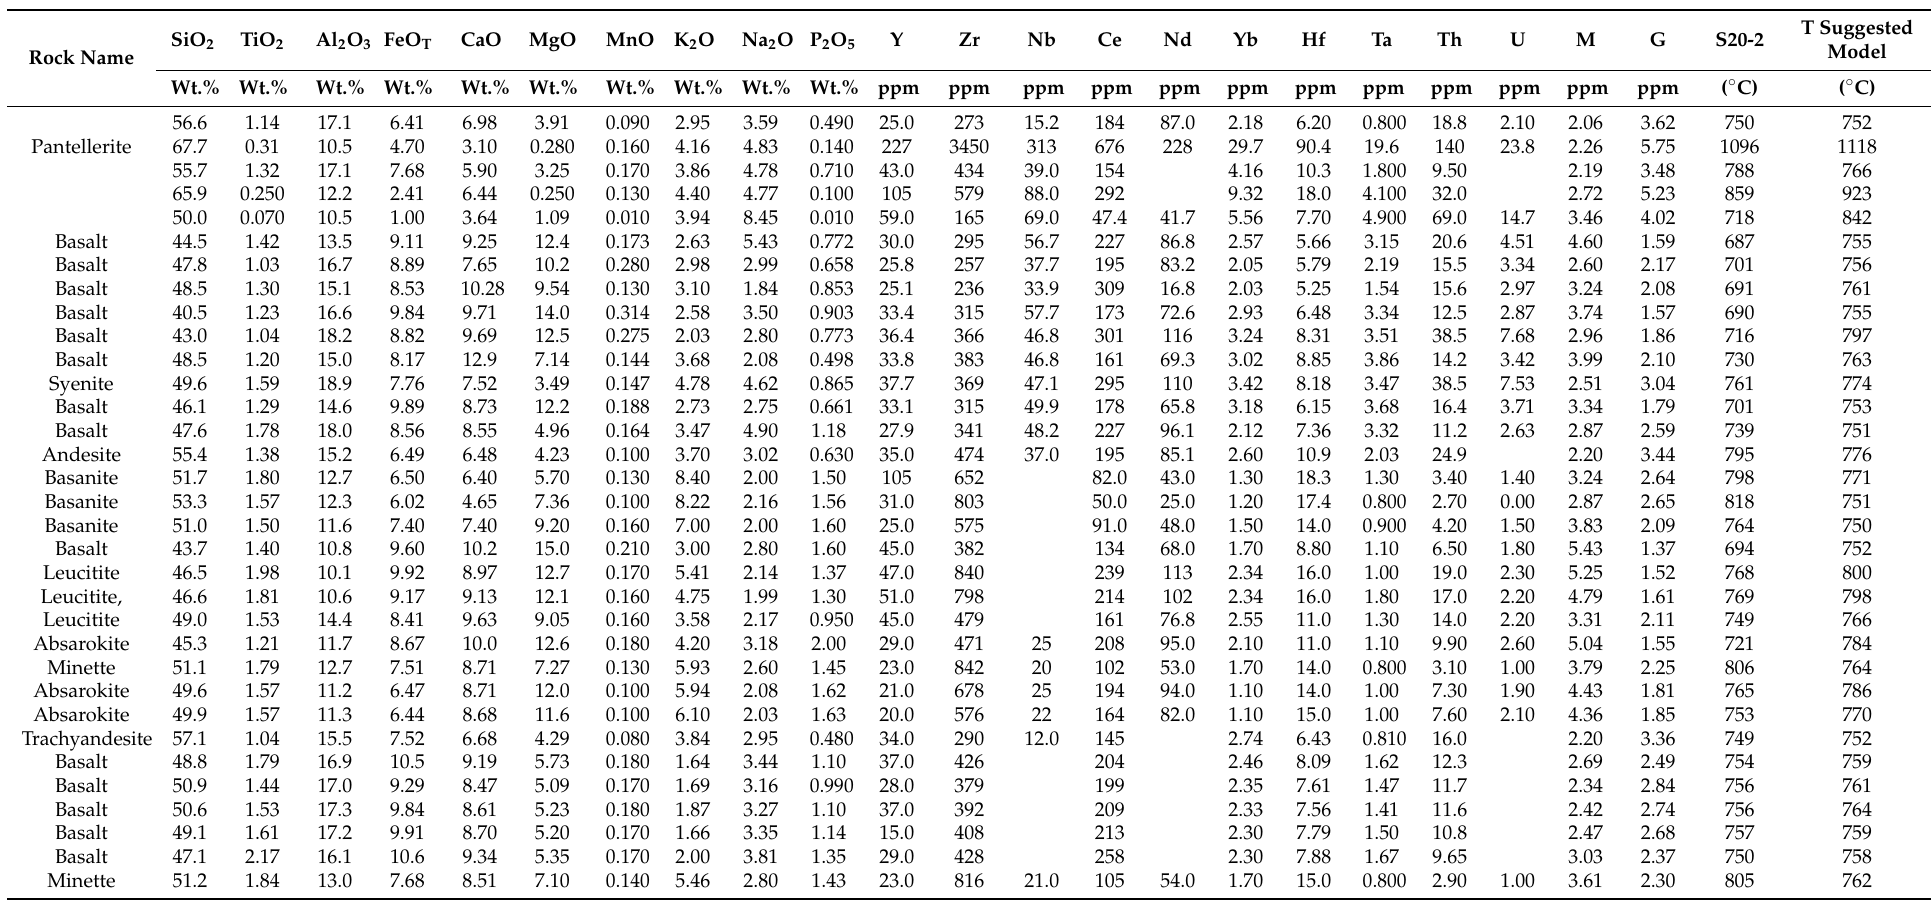
Table 2. The chemical composition of 26 alkaline selected samples from the Basin and Range from geochemical data (http://georoc.mpch-mainz.gwdg.de/georoc/, accessed on 29 August 2021). Temperatures are estimated from the revised T Zr (temperature of zircon saturation) by Shao [36] (S20-2) and our suggested model for alkaline and peralkaline composition rock in degrees